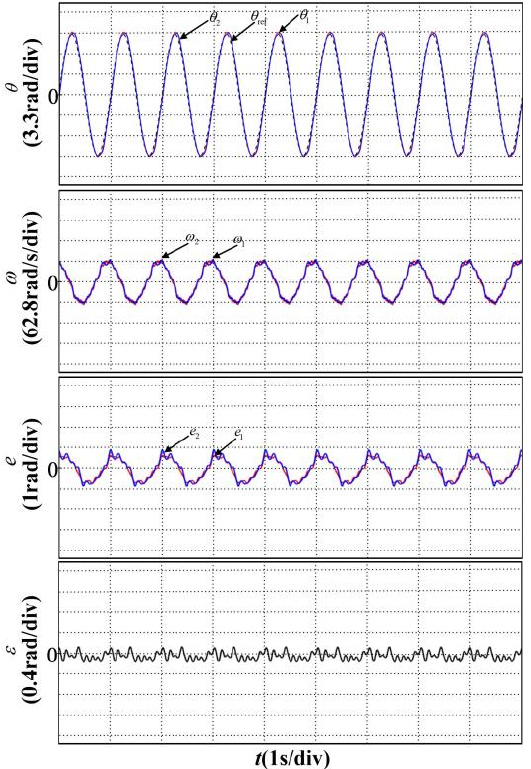
Figure 13. Motor responses when tracking sinusoidal signal.